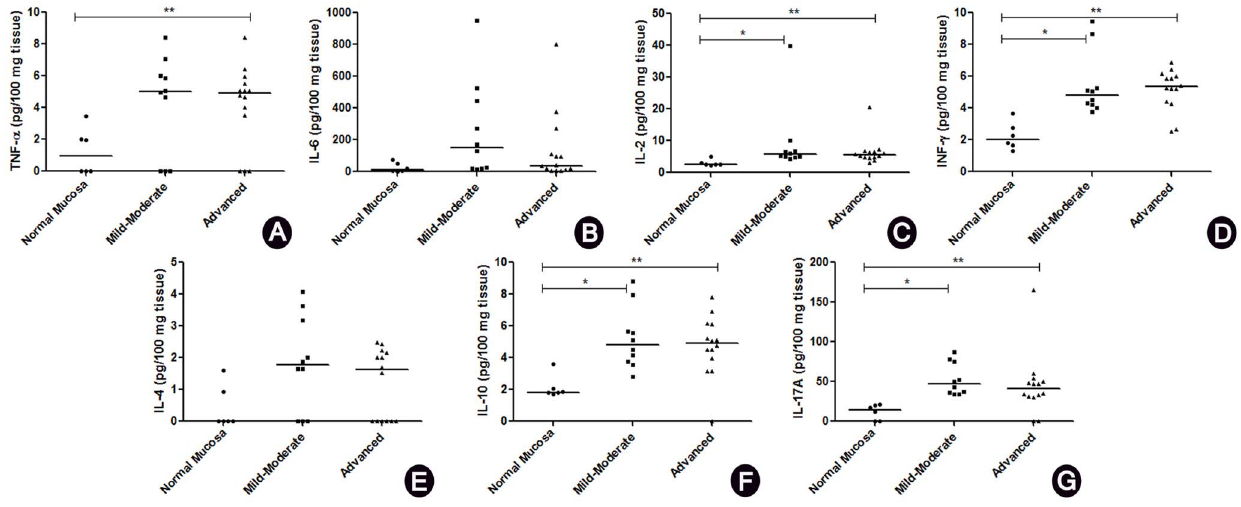
Figure 3. Cytokine levels in individuals with mild-moderate or advanced chronic periodontitis and normal mucosa. Levels of TNF- a (A), IL-6 (B), IL-2 (C), INF- (D), IL-4 (E), IL-10 (F), and IL-17A (G). *Statistically significant difference at P , 0.016 in normal mucosa versus mild-moderate chronic periodontitis. **Statistically significant difference at P , 0.016, in normal mucosa versus advanced chronic periodontitis.